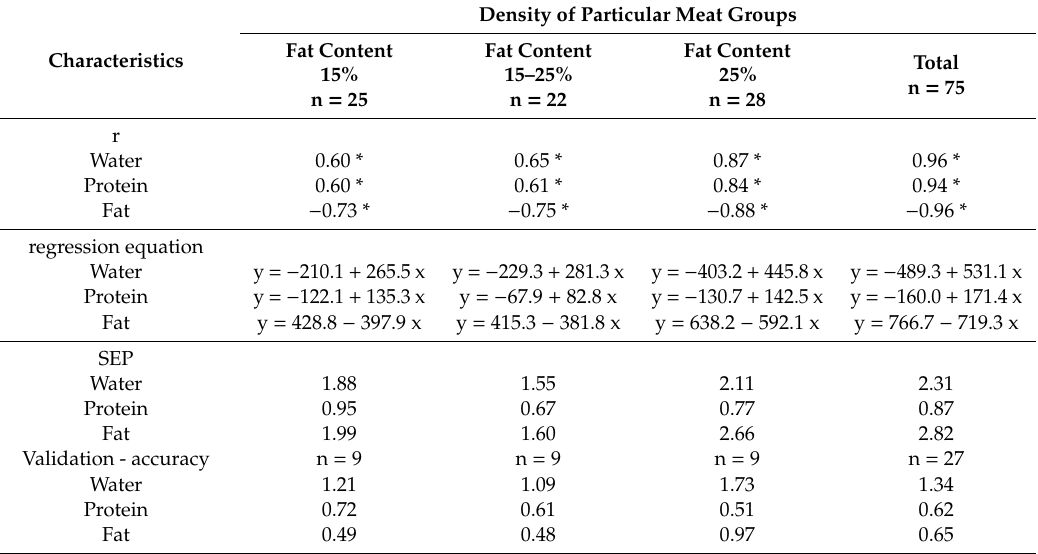
Table 2. Correlation coe ffi cients, regression equations and SEP (Standard Error of Prediction) between density determined by hydrostatic method and basic chemical composition of the analyzed pork meat, method accuracy.